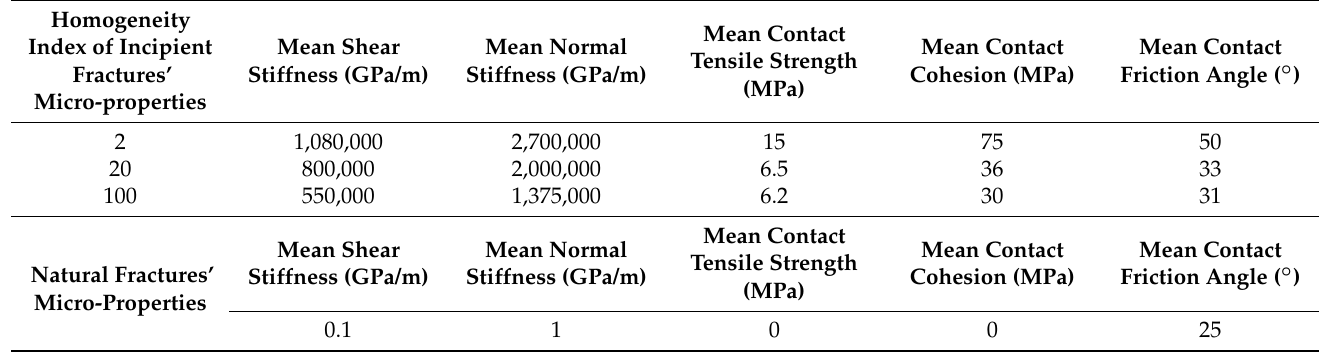
Table 5. Mean micro-properties of incipient fractures after calibration under different homogeneity indexes and micro-properties of natural fracture in the UDEC T-W